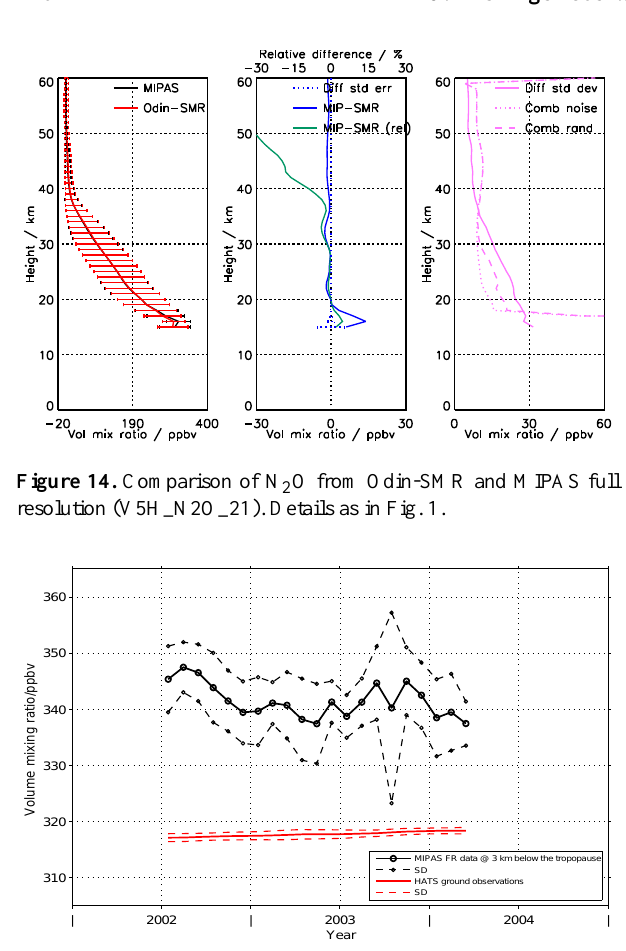
Figure 15. Comparison between volume mixing ratios of N 2 O from HATS and MIPAS full resolution (V5H_N2O_21). Details as in Fig. 4.